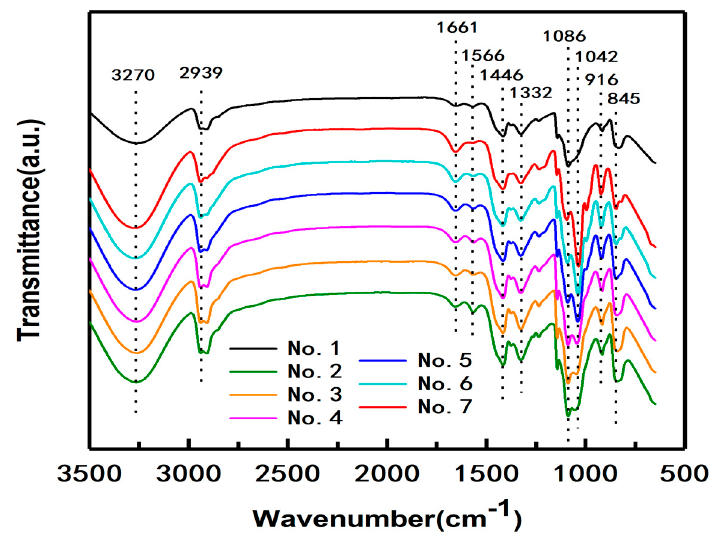
Figure 2. FTIR spectra of the composite films with different CQDs content. Table 1. The experimental scheme and formula of the films.